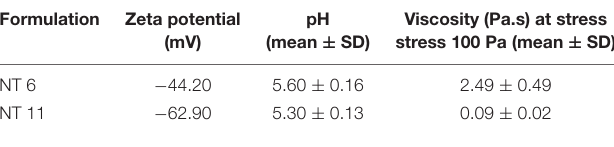
TABLE 2 | Zeta potential, average pH, and viscosity of NT 6 and NT 11 ( n = 3). Formulation